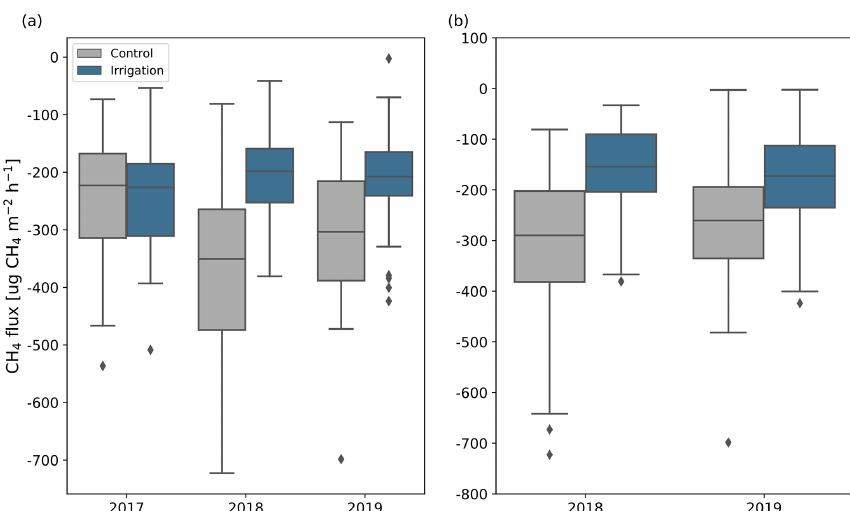
Figure 6. CH 4 fluxes measured by long-term (C1, C4, C6, C8, I2, I3, I4, I9) (a) and all (b) chamber points in May to September in different years. Positive flux values indicate net emission and negative values indicate net uptake. For comparison, the flux of the points located on the irrigated plot in 2018 and 2019 have been calculated already for 2017, even though the irrigation setup was established only in 2018. The boxes show the quartiles of the dataset and the horizontal line inside the boxes is the median flux. Whiskers show the range of the data, except for the points that are determined to be outliers, which are shown with black diamonds.